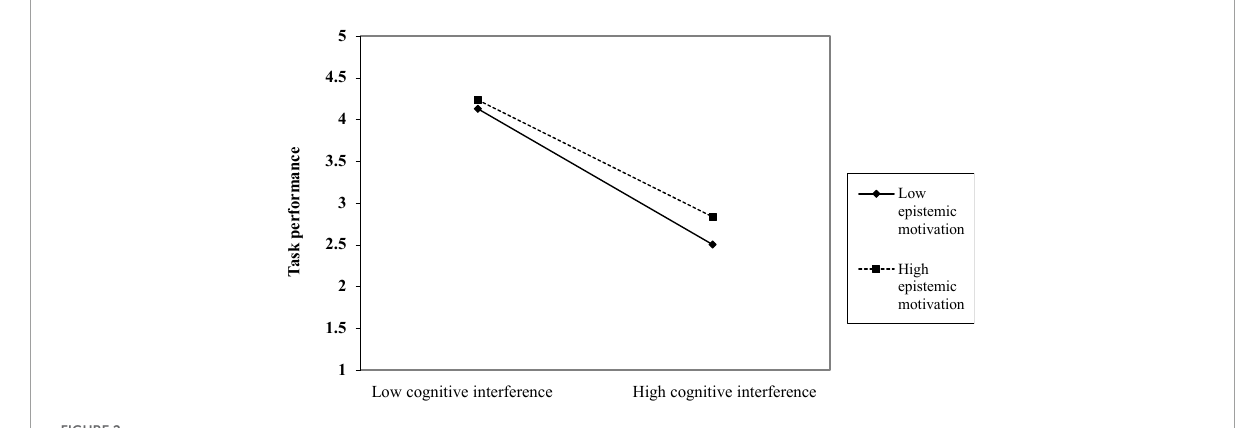
FIGURE2 The moderating effect of epistemic motivation on the relationship between follower cognitive interference and task